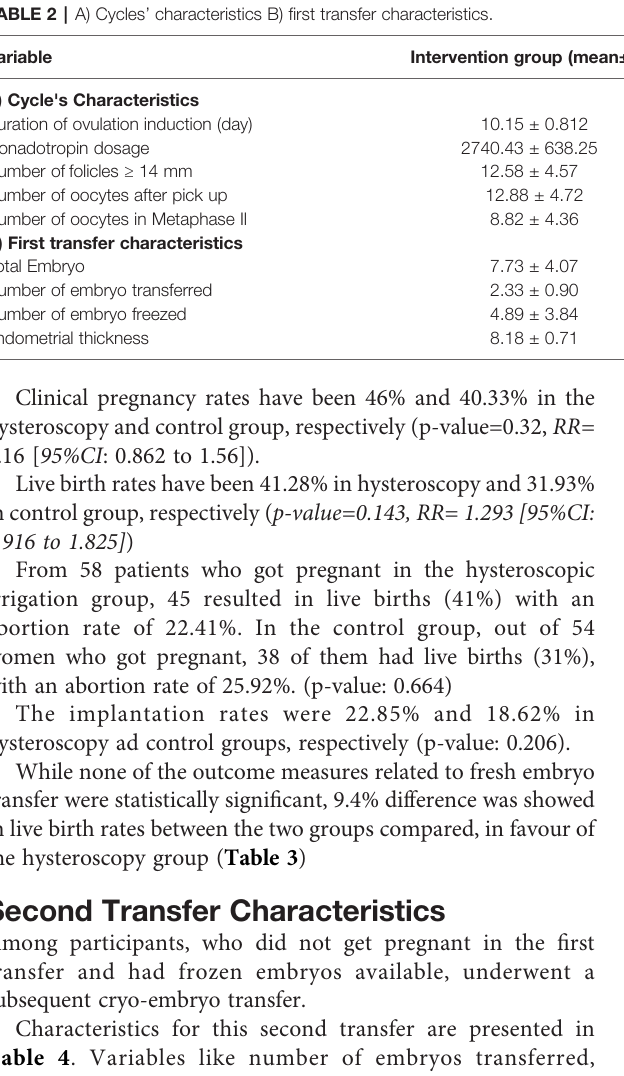
Table 4 . Variables like number of embryos transferred, endometrial thickness, day of embryo transfer were compared and did not reveal any signi fi cant differences.